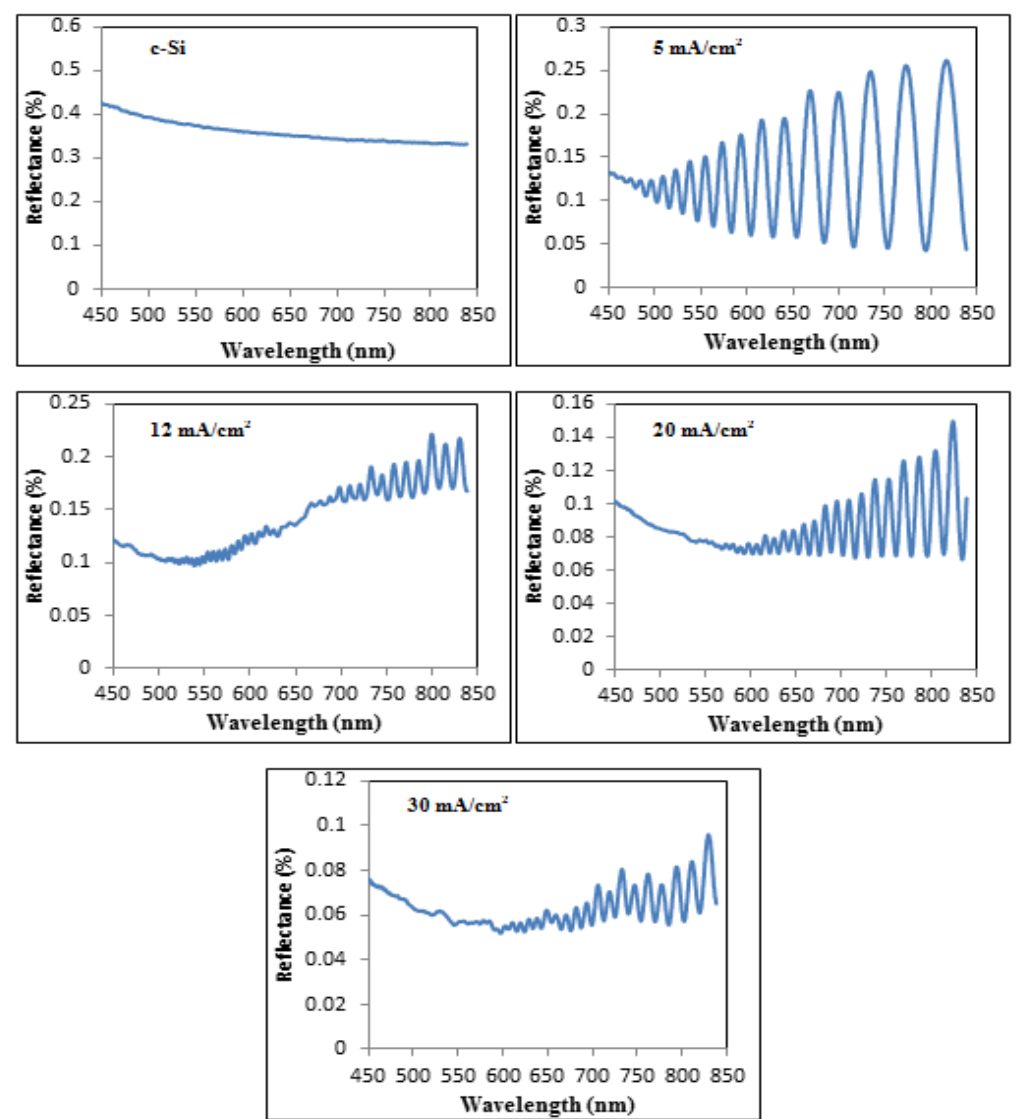
Fig. 3: The Reflectance spectrum for c-Si and PS prepared at different etching current density (J = 5, 12, 20 and 30 mA/cm 2 ), etching time was 15 min and the HF concentration was